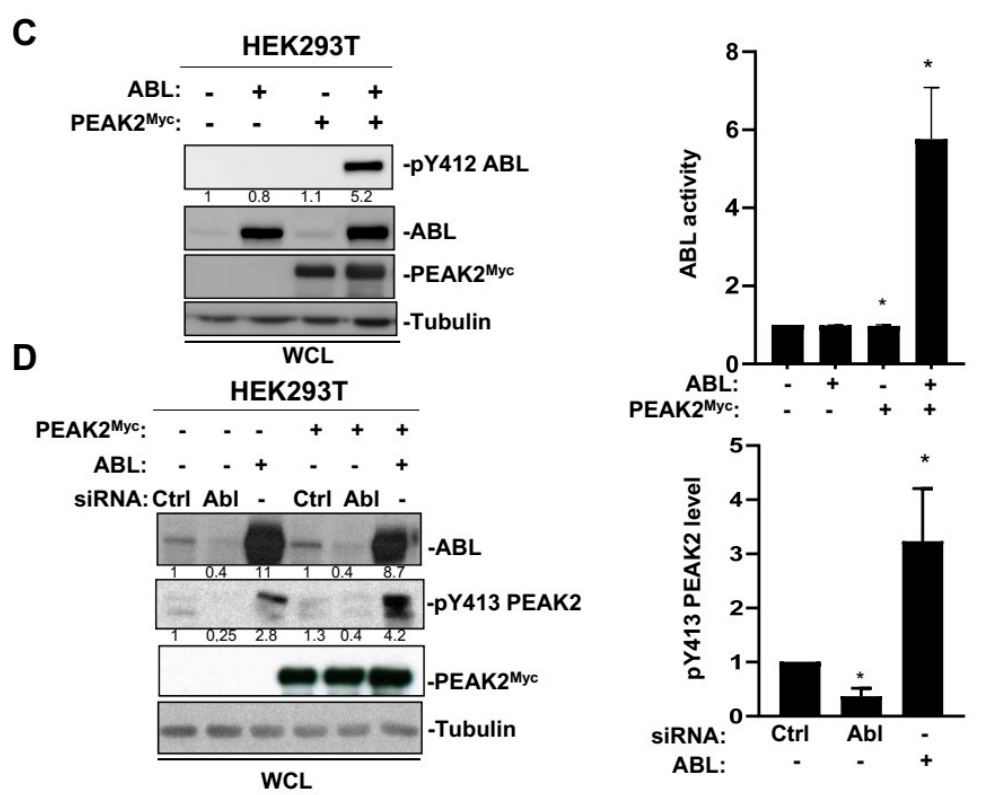
Figure 5. Phosphoproteomic analyses identified ABL as a novel PEAK2 target. ( A ) Workflow of the phosphoproteomic analysis of PEAK2 signalling in HEK293T cells. ( B ) Heatmap of phosphotyrosine peptides that show a log 2 fold change (FC) ≥ 1.5 upon PEAK2 Myc expression in 2 out 3 biological independent experiments. Missing values are shown in black. ( C ) PEAK2 induces ABL tyrosine phosphorylation and activation. ( D ) ABL induces PEAK2 phosphorylation on Y413. The levels of PEAK2 Myc , ABL, pY413 PEAK2, and pY412 ABL in HEK293T cells transfected with indicated reagents are shown. Right panels represent the relative quantification of indicated signals (mean ± SEM; n = 3–4; * p < 0.05; Student’s t